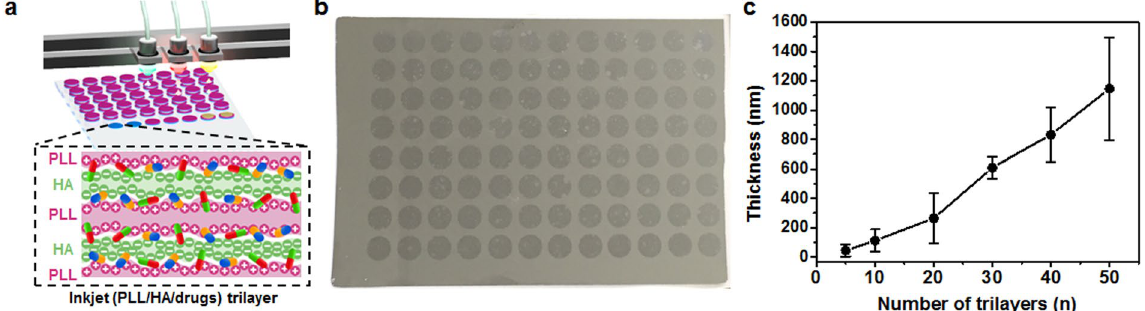
Figure 2. ( a ) Schematic illustration of fabrication of printed (PLL/HA/drugs) trilayer based mutilayer nanofilms for the high-throughput immunosuppressive drug screening and chemical structures of immunosuppressive drugs (MPA, RAPA, Cyc A) (The figure was drawn by M.C). ( b ) Digital image of a 96-well plate as a printed shaped on the silicon wafer. ( c ) Thickness profile analysis of (PLL/HA) n , (n = bilayers) printed multilayer nanofilms as measured by a mechanical